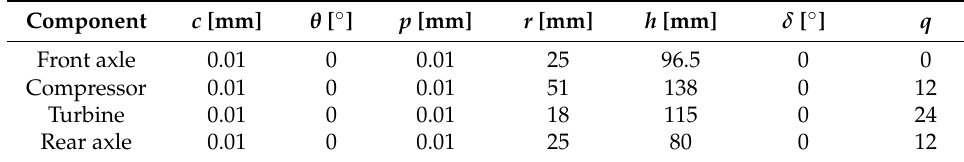
Table 1. The setup of the geometric parameters of the high-pressure rotor system.